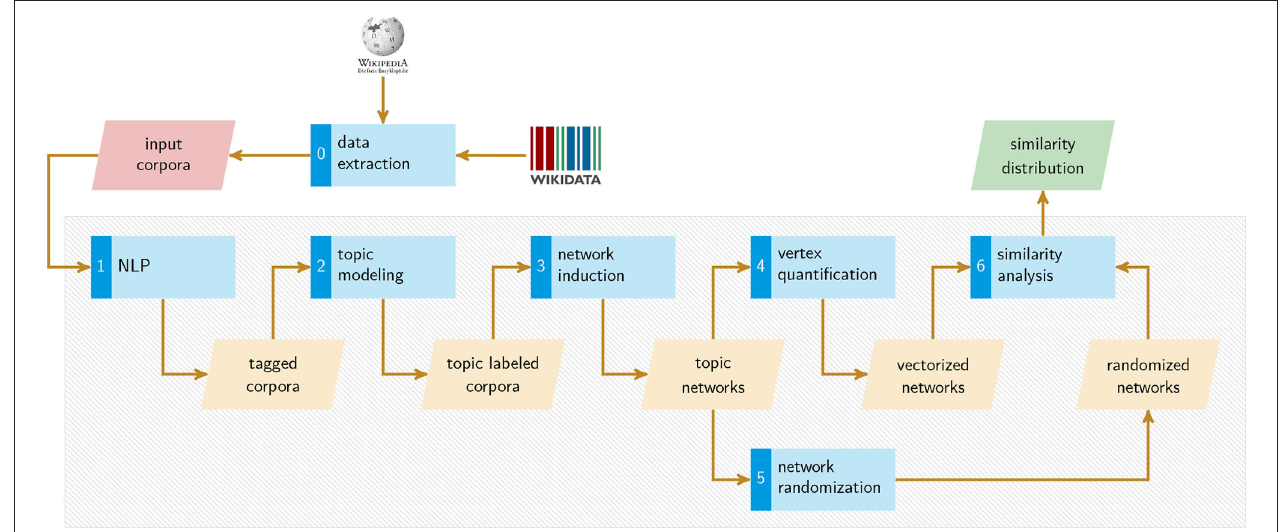
FIGURE 7 | A procedure for measuring the similarity of thematically homogeneous article networks.